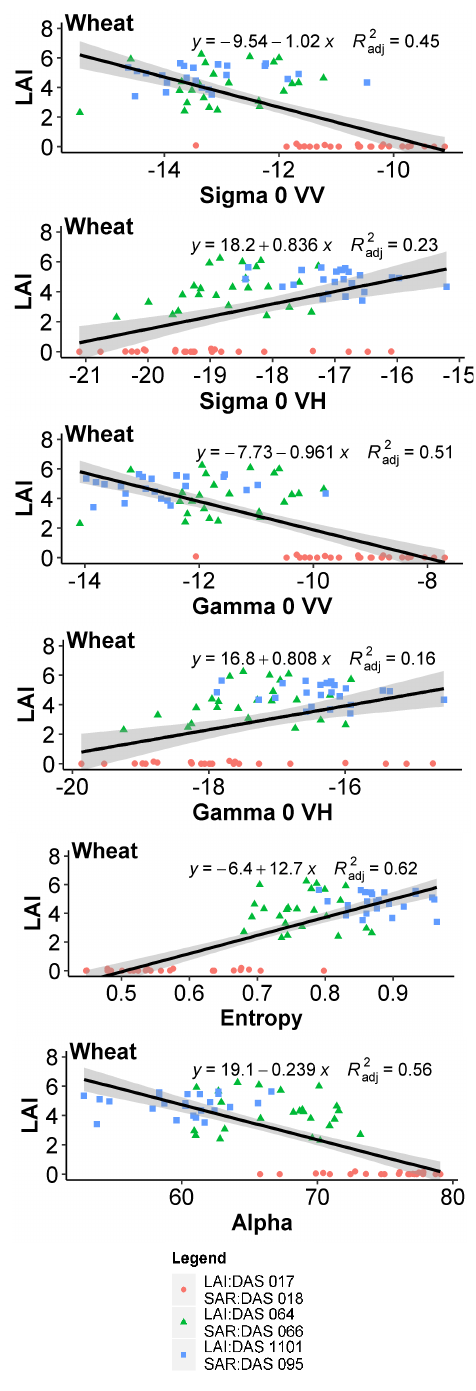
Figure 9. Relationship between LAI and Sigma, Gamma, Entropy and Alpha angle for wheat.